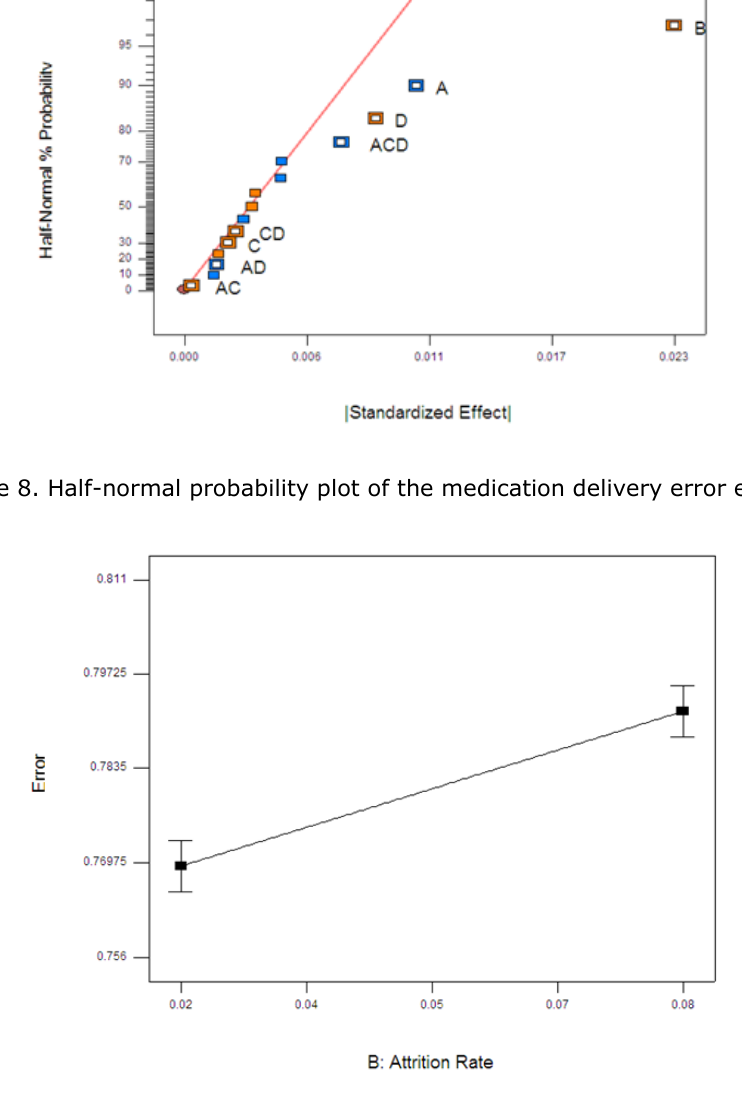
Figure 9. Main effect of the attrition rate versus medication delivery error